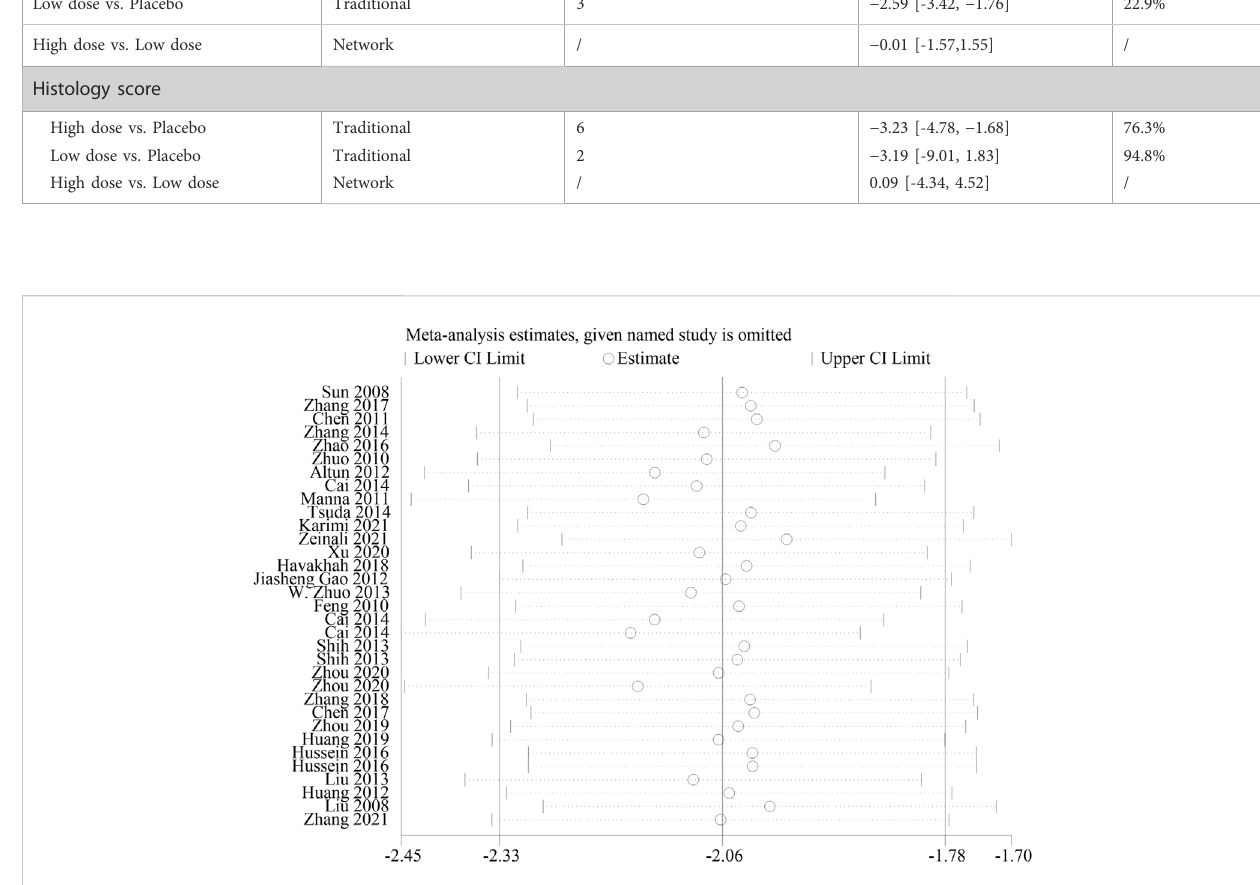
FIGURE 9 Sensitivity analysis